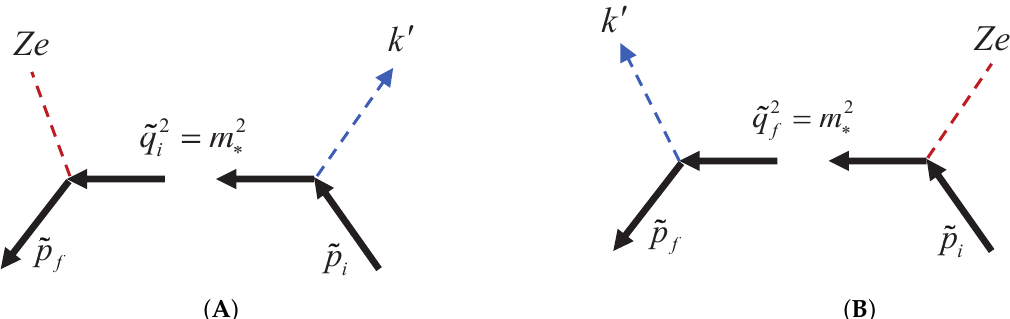
Figure 1. Resonant spontaneous bremsstrahlung of an electron in the field of a nucleus and a plane electromagnetic wave. Reaction channels ( A , B